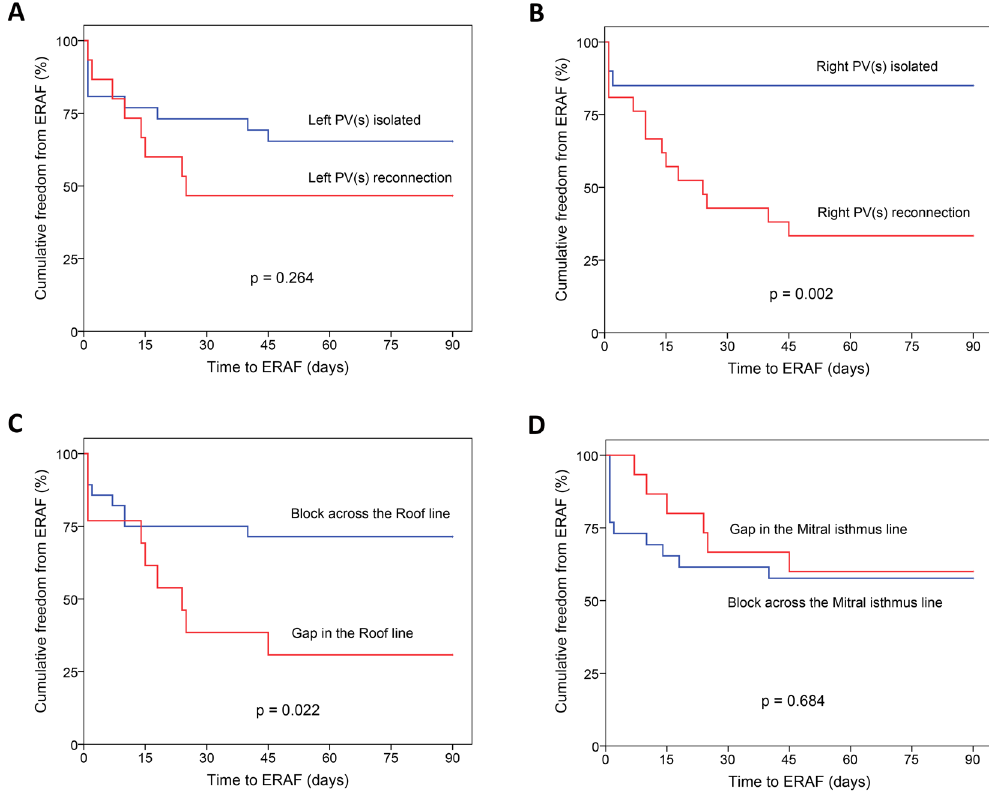
Figure 2. Kaplan-Meier curves of freedom from ERAF during the blanking period after the index ablation in patients grouped by 3-month integrity of the left PVI lesion ( A ), the right PVI lesion ( B ), the Roof line ( C ) and the Mitral isthmus line ( D ).ERAF, early recurrence of atrial fibrillation; PVI, pulmonary vein isolation.